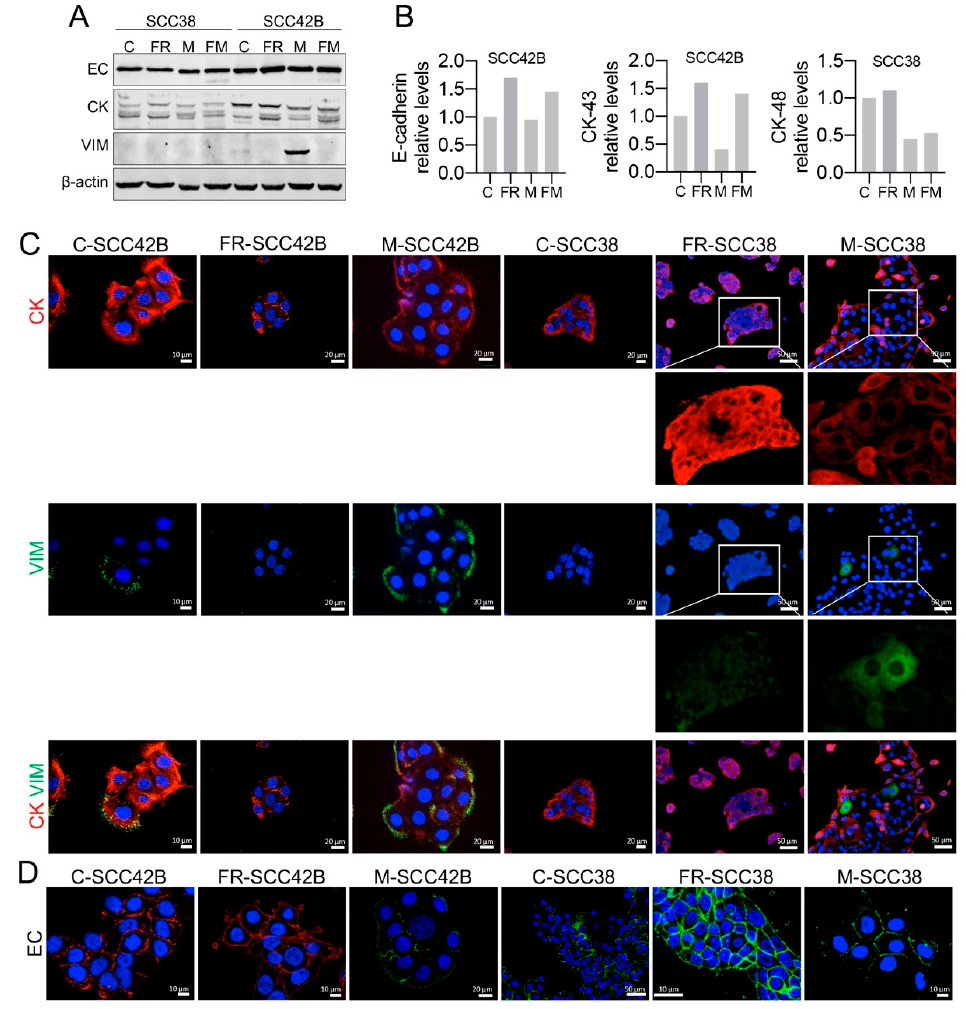
Figure 8. Expression of epithelial / mesenchymal biomarkers in association with FAK / MMP-2 in SCC cells ( A ) Western blot analysis showing expression of EC, CK and VIM in SCC cells infected with empty vector ( C ) or in SCC cells expressing FRNK (FR), MMP-2 (M) or FRNK + MMP-2 (FM). The membranes were stripped and reprobed with anti- β -actin antibody to assure even loading of proteins in each lane. The ratios EC, CK or VIM/ β -actin were estimated by densitometry ( B ). ( C , D ) Representative images of immunostaining of the indicated cells for CK (red) plus VIM (green) ( C ) or EC (red or green) ( D ). Insets in panel ( C ) highlight the loss of CK and gain of VIM in M-SCC38 cells compared with FR-SCC38 cells.